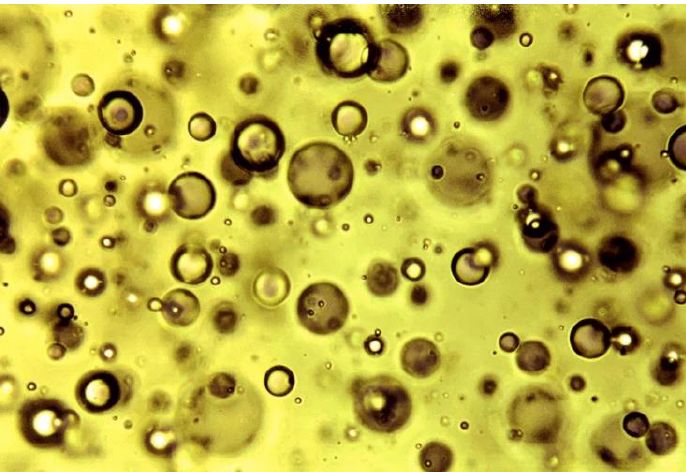
Figure 3. Microdroplets of a water-in-oil (W/O) extra virgin olive oil emulsion with 3% w/w of water, observed with a light microscope at a magnification of 400, emulsified with Ultra-Turrax. Droplet size distribution is a function of numerous factors, such as time/energy, temperature, type and concentration of surfactants [70] .